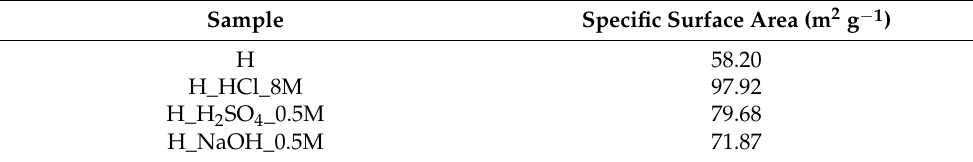
Table 3. Speci fi c surface area of modi fi ed and unmodi fi ed halloysite samples. Table 3. Specific surface area of modified and unmodified halloysite